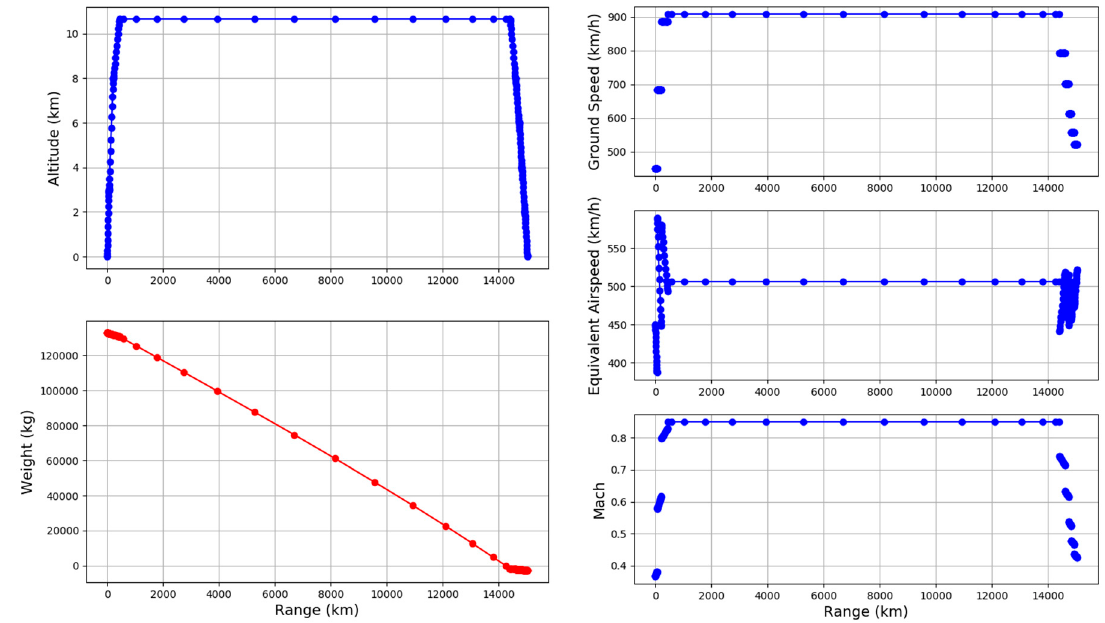
Figure A5. Mission performance of SE²A-LR.